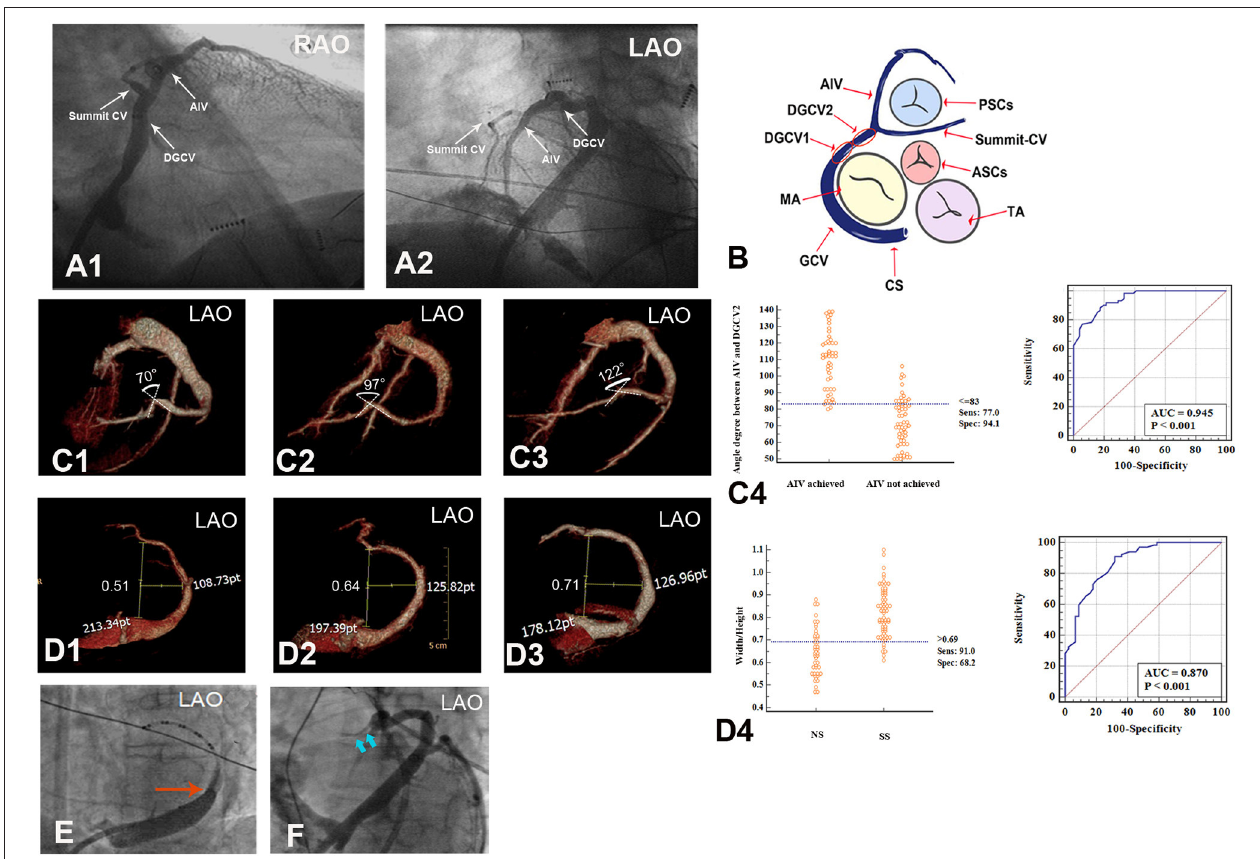
FIGURE 2 | Anatomy of DGCV-AIV and anatomic obstacles preventing catheterization in GCV. (A,B) Anatomy of DGCV-AIV. (C,D) Anatomic obstacles preventing catheterization in GCV. (D) Angle formed between DGCV and AIV, and an angle < 83 ◦ prevented the ablation catheter from advancing from DGCV into AIV. (E) Different morphology of GCV, and Width/Hight>0.69 more favored the application of the SS approach. (E) Venous valve (Vieussens valve) in GCV. (F) Thin lumen of summit-CV. DGCV, distal great cardiac vein; AIV, anterior interventricular vein; summit-CV, communicating vein in the left ventricular summit. RVOT, right ventricular outflow tract; LVOT, left ventricular outflow tract; TA, tricuspid annulus; MA, mitral annulus; CS, coronary